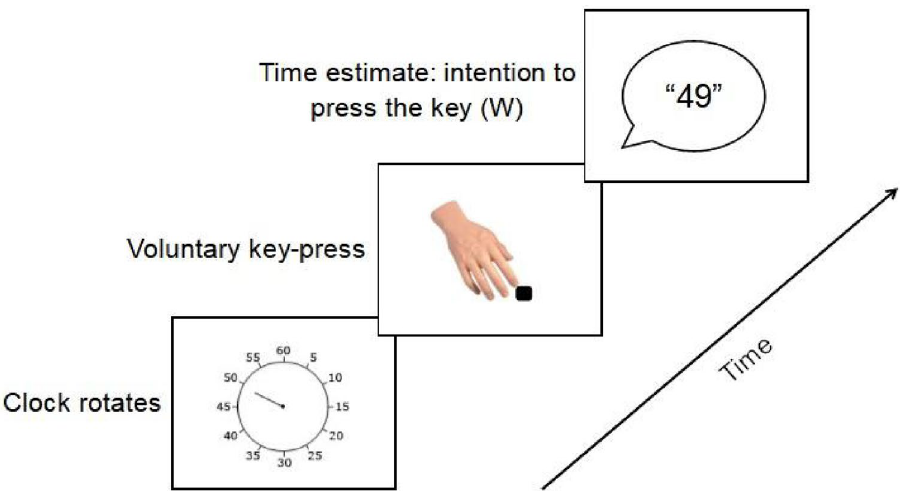
Figure 1. Standard trial structure across all experiments. Participants were required to press a key at their own pace and report the time they first became aware of their intention to press the